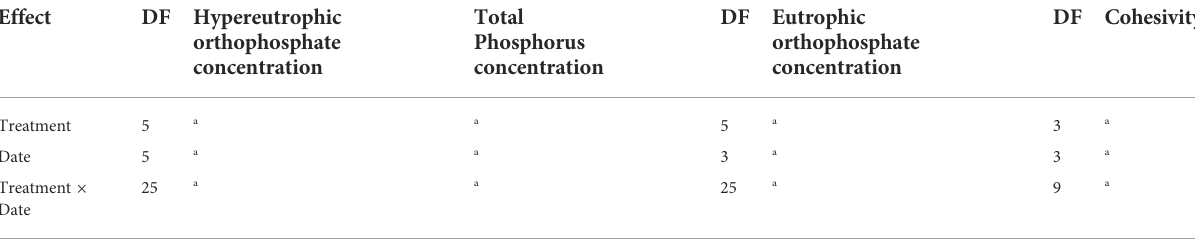
Total DF Eutrophic Phosphorus orthophosphate concentration